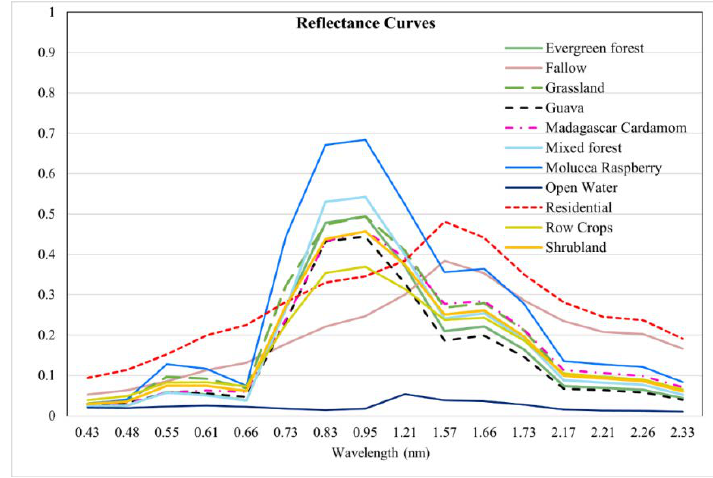
Figure 17. Reflectance spectra of all classes, showing the overlapping reflectance spectra for vegeta- tion classes—for example between Evergreen Forest, Grassland, and Mixed Forest.